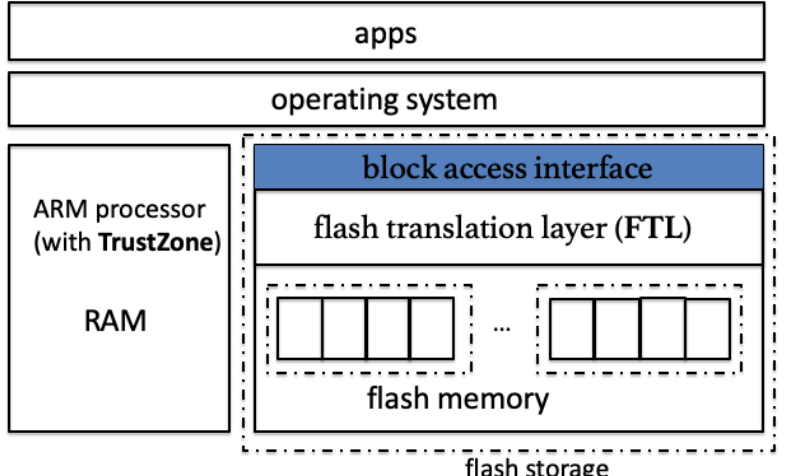
Figure 3. The architecture of a mobile